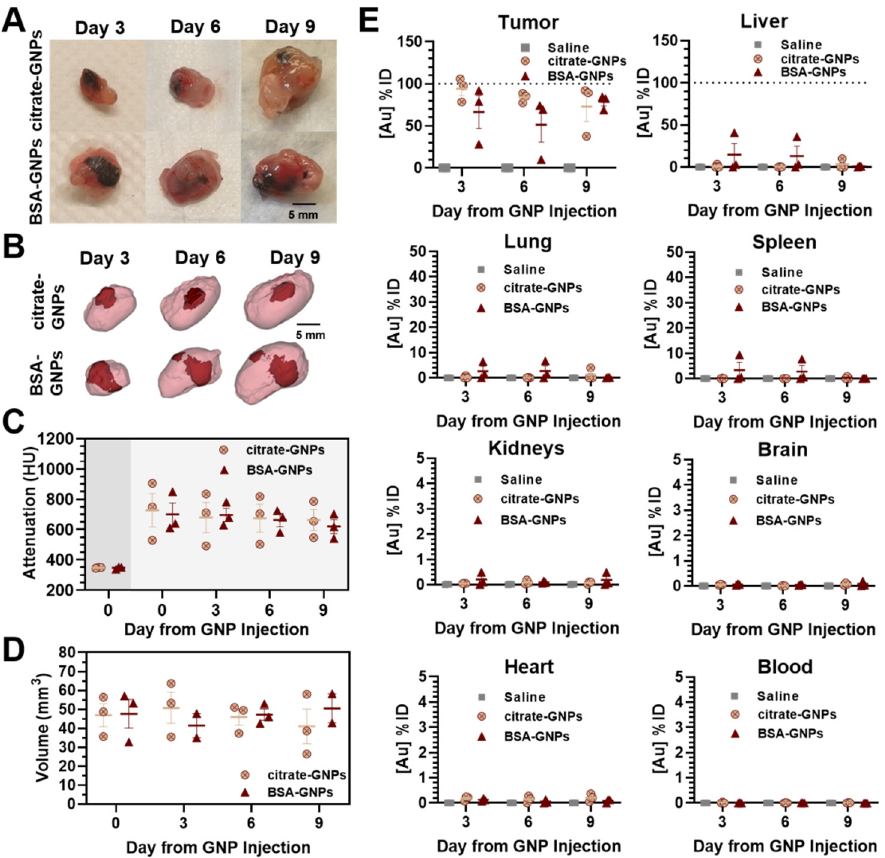
Figure 6. Micro-CT and ICP-OES demonstrate particle distribution at different time points after high-dose intratumoral injection using an injection pump. ( A ) Ex vivo LLC solid tumors at different sacrifice time points. ( B ) three-dimensional renderings of the intratumoral biodistribution of citrate-GNPs and BSA-GNPs from micro-CT images. Residual intratumoral GNPs are rendered in dark red, tumor tissue is rendered in pink (40% transparency). ( C ) Mean attenuation values in Hounsfield units (HU) calculated within the GNP cluster volume over time using CT follow-up images (GNP pre-injection: dark gray area; GNP post-injection: dark gray area). ( D ) GNP cluster volume over time calculated using CT follow-up images. ( E ) Biodistribution of citrate-GNPs and BSA-GNPs in digested tumors, organs (liver, lung, spleen, kidneys, brain, heart), and blood over time ( n = 3 mice per group) using ICP-OES. Saline injections were performed on 3 mice as a negative control group. All data in the figure are reported as mean ± standard error of the mean (s.e.m). Dashed lines represent 100% of the injected dose.